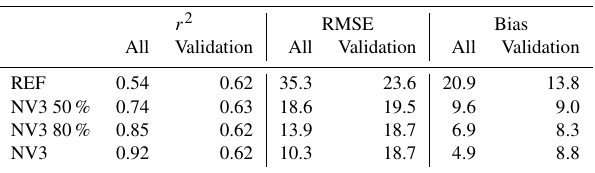
Table 4. Average of coefficient of determination, root mean square error and absolute bias at all surface stations and at surface valida- tion stations only for different FLEXPART CTM simulations. The percentage refers to the number of nudging locations that were in- cluded in the simulation. r 2 RMSE Bias All Validation All Validation All Validation